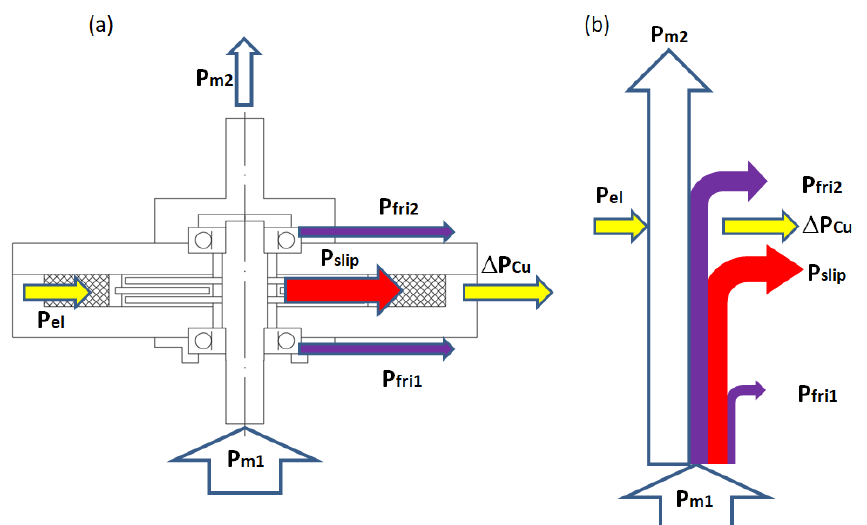
Figure 1. Cross-section of multi-disc MR clutch: ( a ) mechanical and electrical sources of heat and ( b ) power flow diagram in transient states or in steady state with slippage where P m 1 —input mechanical power; P m 2 —output mechanical power; P el —input active electrical power; P slip —slip power (related to slip heat generated in MR fluid in transient states); ∆ P Cu —copper losses (Joule heat); P fri 1 —mechanical power losses in bearings of driving member; P fri 2 —mechanical power losses in bearings of primary (driving)